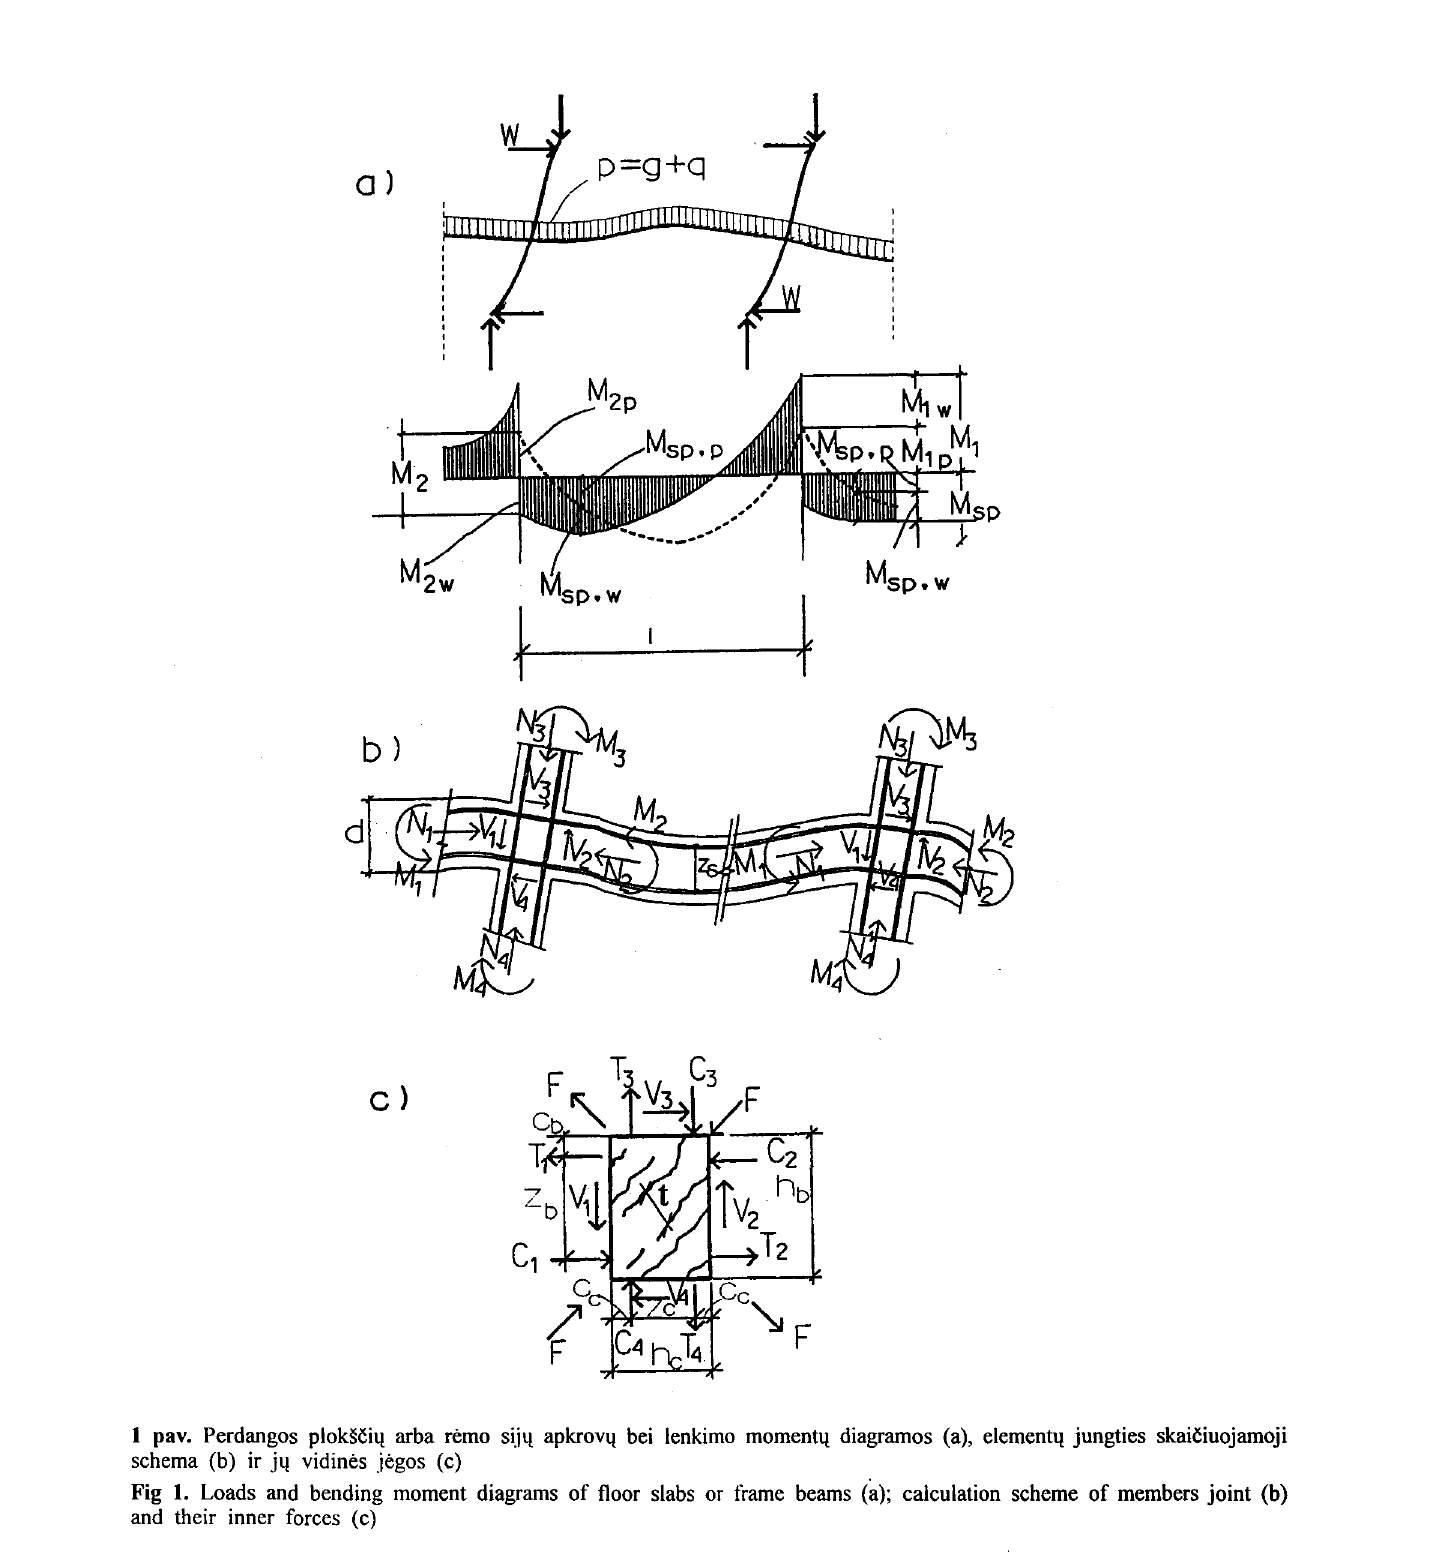
Fig 1. Loads and bending moment diagrams of floor slabs or frame beams (a); calculation scheme of members joint (b) and their inner forces